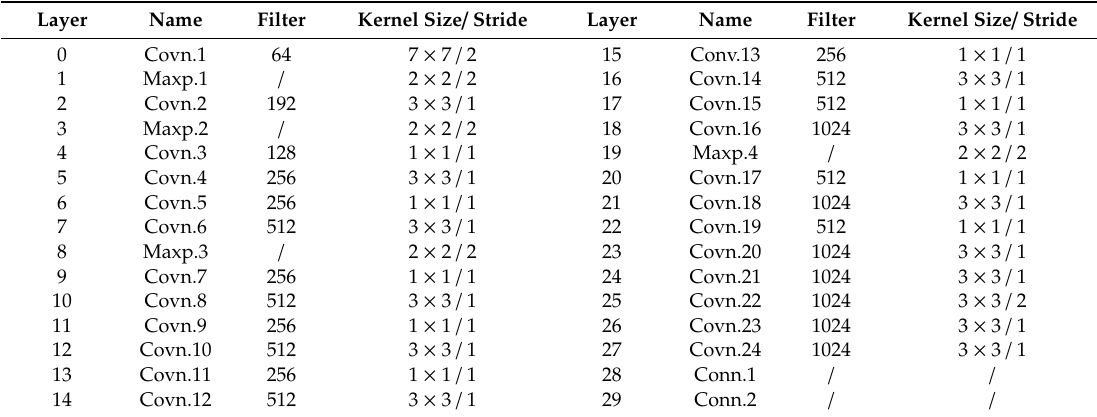
Table 1. Architecture of